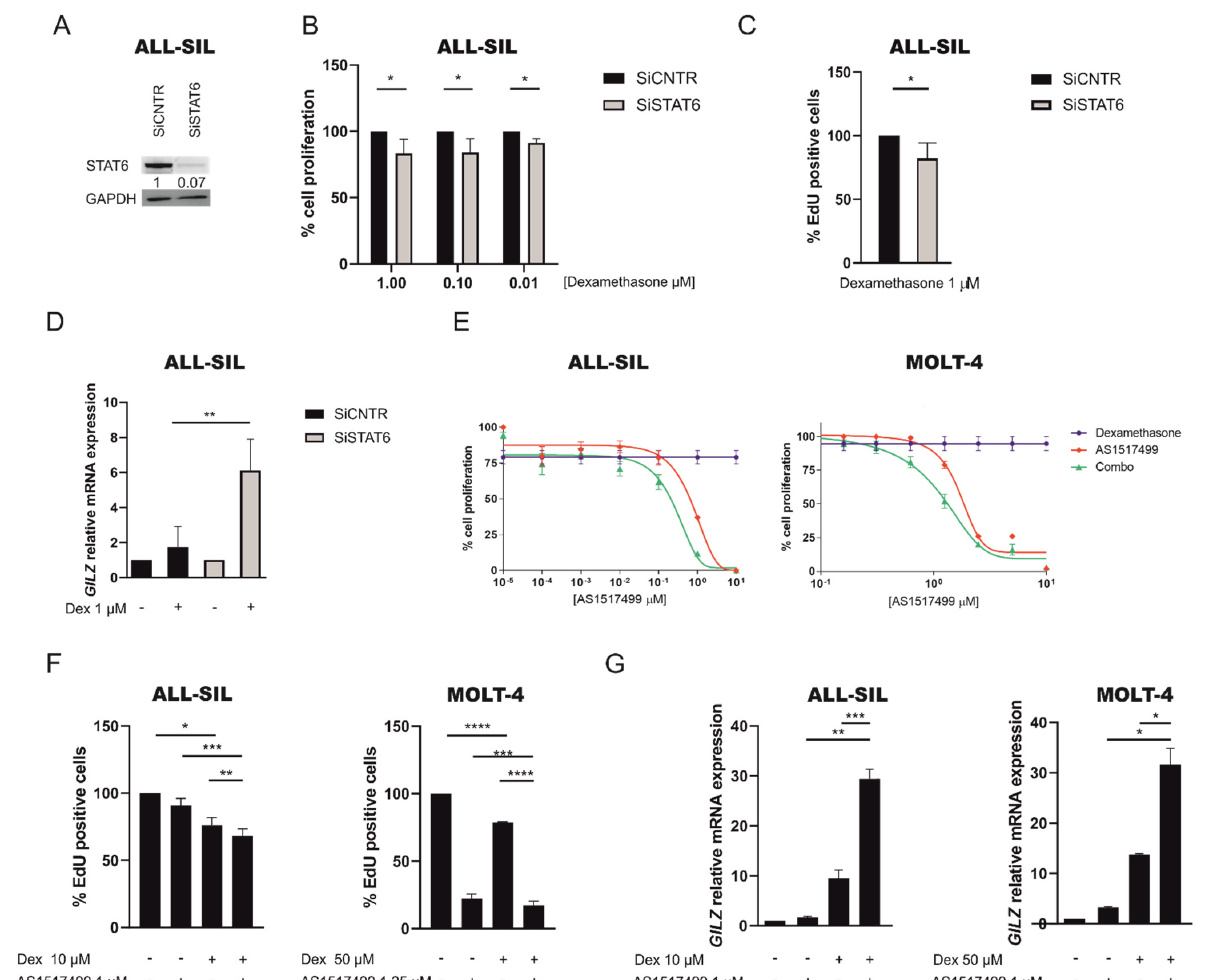
Figure 4. Inhibition of STAT6 sensitizes GC resistant cells to the action of dexamethasone. ( A ) WB analysis of STAT6 protein expression in ALL-SIL cells control (SiCNTR) and silenced (SiSTAT6) after 48 h of silencing. ( B ) ALL-SIL cell proliferation was determined by MTT test after specific gene silencing of STAT6 and treatment with dexamethasone at scalar doses for 48 h. Cell proliferation of control cells was set to 100%. Results are presented as means ± SEM (at least n = 3 for all the experiments). ( C ) Percentage of EdU positive cells in ALL-SIL SiCNTR and SiSTAT6 cells after treatment with dexamethasone at 1 μ M for 48 h. Cell proliferation of control cells was set to 100%. Results are presented as means ± SEM. ( D ) GR transcriptional activity measured by GILZ mRNA levels in ALL-SIL cells control and STAT6 silenced after treatment with DMSO or dexamethasone (1 µ M) for 6 h. Results are presented as means ± SEM ( n = 3). ( E ) Cell proliferation, determined by MTT test, in ALL-SIL and MOLT-4 cells after 48 h of treatment with scalar doses of AS1517499 and fixed dose of dexamethasone, 10 µ M or 50 µ M, respectively, for ALL-SIL and MOLT-4 alone or in combination. Results are presented as means ± SEM ( n = 3). ( F ) Percentage of EdU positive cells in ALL-SIL and MOLT-4 cell lines after treatment with DMSO, AS1517499 (1 µ M) and dexamethasone at (10 µ M or 50 µ M) alone or in combination for 48 h. Cell proliferation of control cells was set to 100%. Results are presented as means ± SEM ( G ) GR transcriptional activity measured by GILZ mRNA levels in ALL-SIL and MOLT-4 treated with DMSO, AS1517499 (1 µ M) and dexamethasone (10 µ M or 50 µ M) alone or in combination over-night. Results are presented as means ± SEM, ( n = 3 at least for all experiments). (* p < 0.05; ** p < 0.01; *** p < 0.001; **** p < 0.0001. paired t